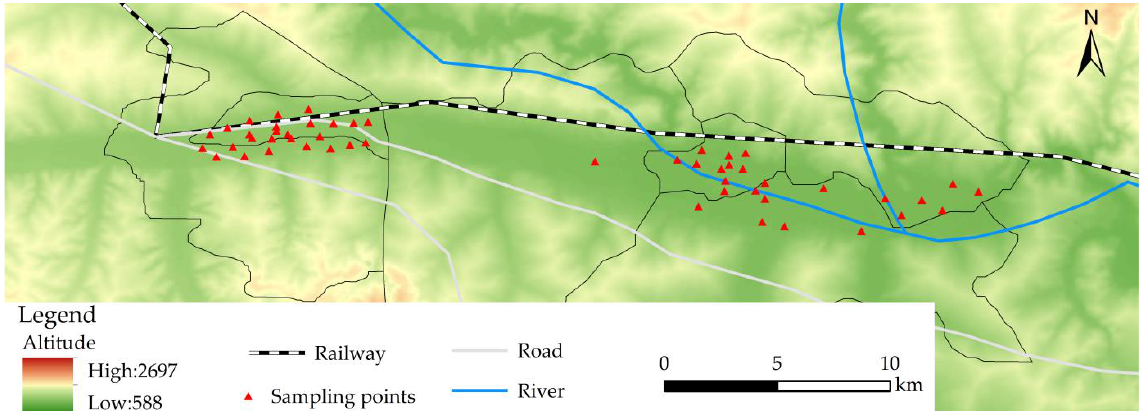
Figure 1. A schematic map of the study area and sampling points location.